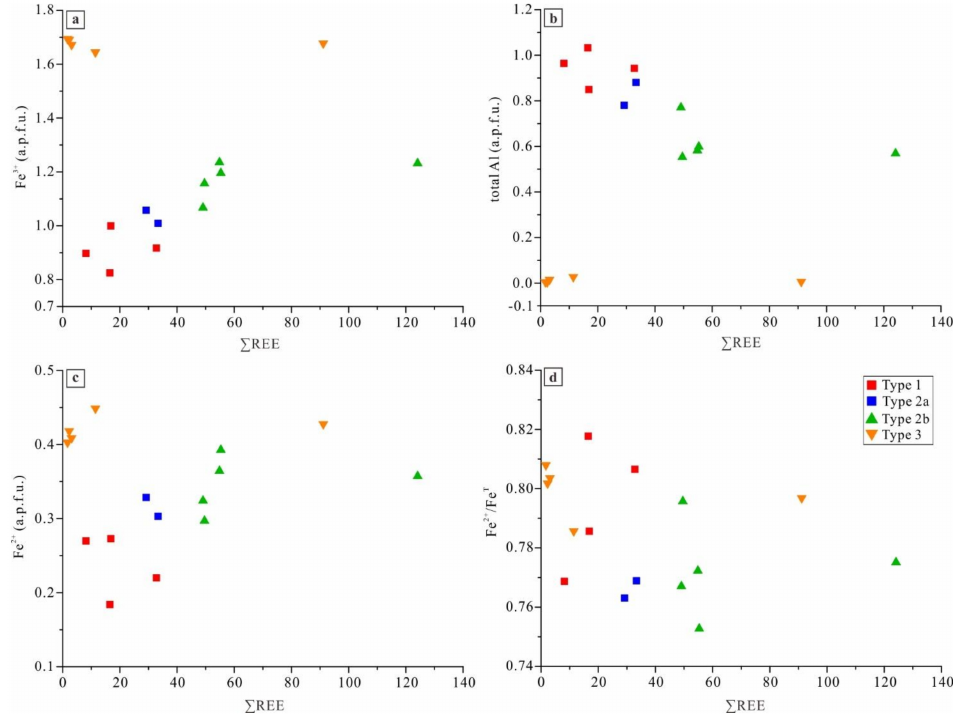
Figure 12. Plots of ∑ REE 3+ with ( a ) Fe 3+ , ( b ) total Al, ( c ) Fe 2+ and ( d ) Fe 3+ /Fe T (a.p.f.u., in atoms per formula unit) for garnets in the Laoshankou